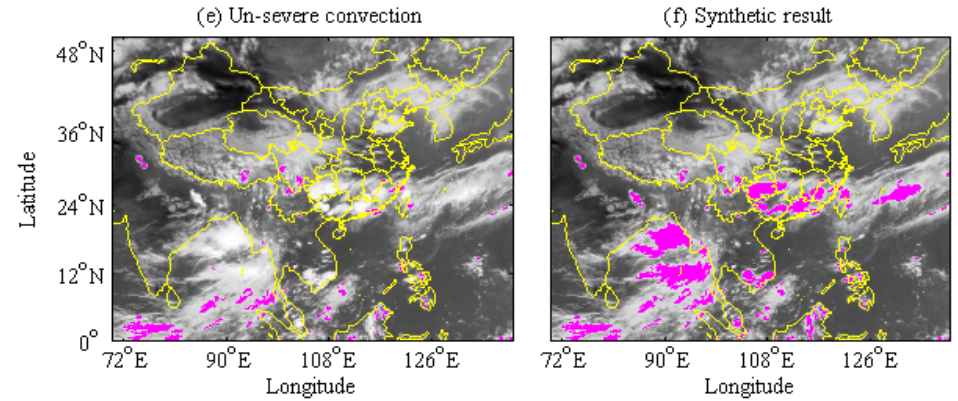
Figure 7. ( a – f ) Results after each detection step. The pink area on the image is the detection result.